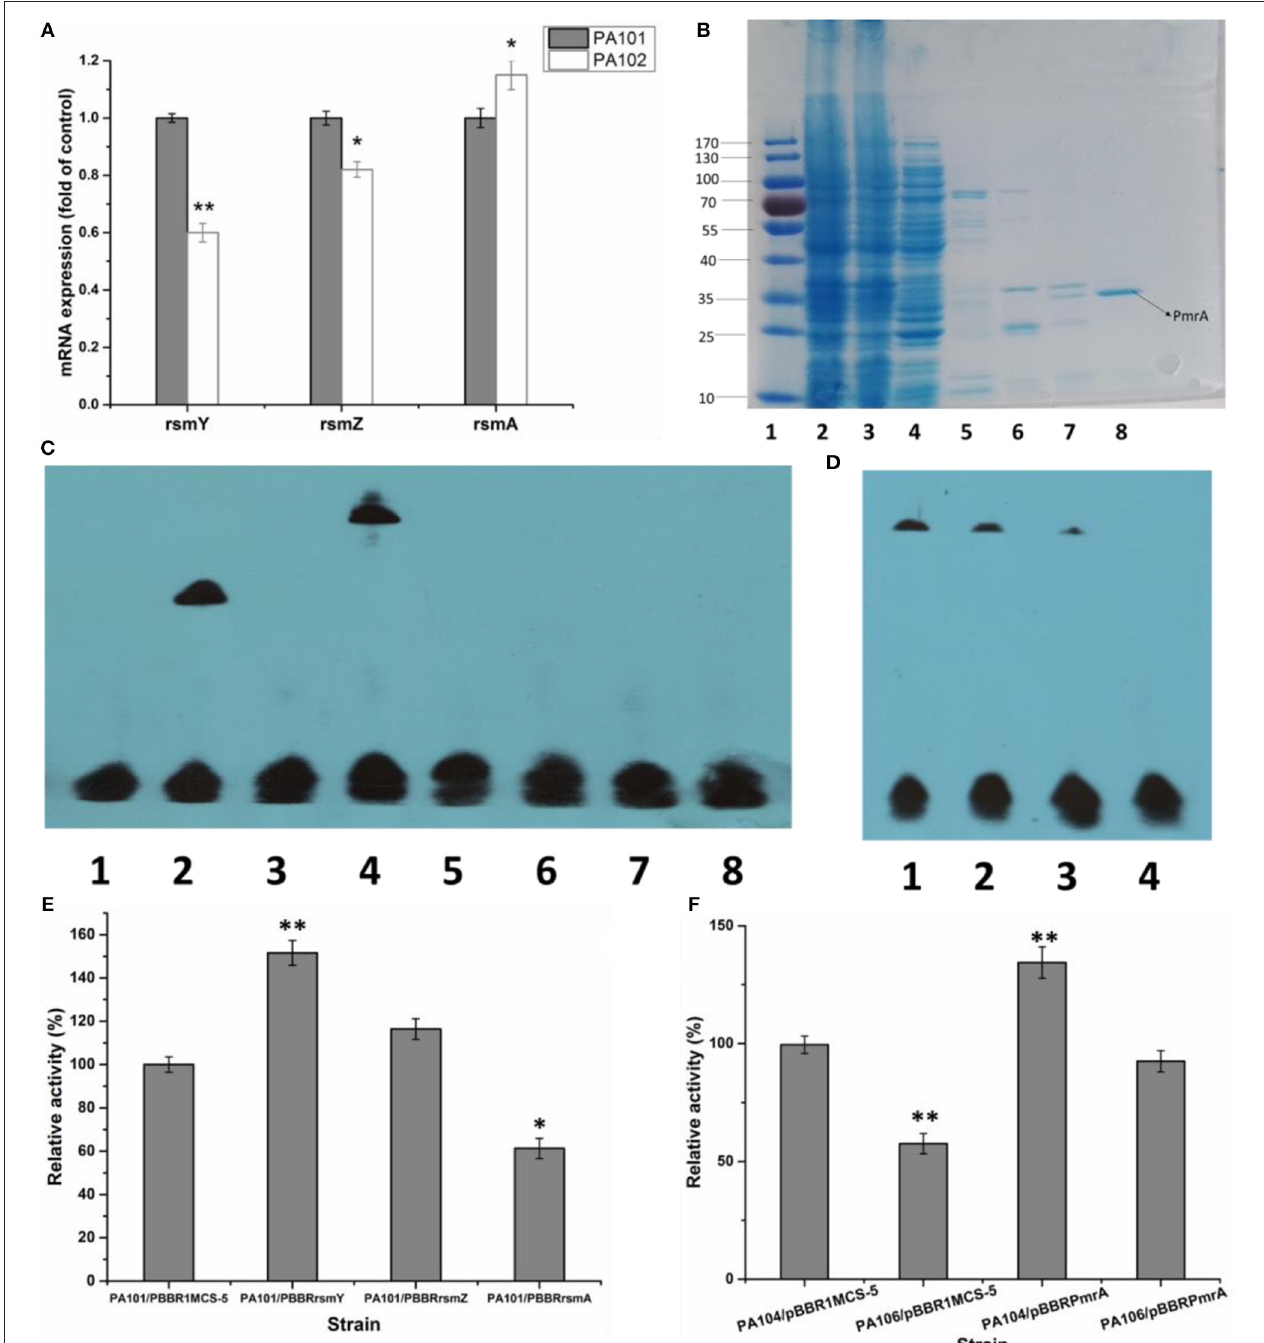
FIGURE 3 | Effect of PmrA overexpression on lipA expression. (A) QRT-PCR of rsmY , rsmZ, and rsmA in control strain (PA101; lane 1) and PmrA mutant strain (PA102; lane 2). Experiments were in triplicate. * P < 0.05, ** P < 0.01 compared with control group. (B) SDS PAGE of purified PmrA protein. Lane 1: protein molecular weight marker. Lane 2: whole cell lysate. Lane 3: liquid behind the column. Lane 4: NTA-30. Lane 5: NTA-60. Lane 6: NTA-100. Lane 7: NTA-200. Lane 8: NTA-500. (C) EMSA for binding of PmrA to rsmY/Z/A promoter sequence. Lane 1: negative control ( − ). Lane 2: positive control ( + ). Lane 3: rsmY. Lane 4: rsmY + PmrA. Lane 5: rsmZ. Lane 6: rsmZ + PmrA. Lane 7: rsmA. Lane 8: rsmA + PmrA. (D) PmrA protein bound to rsmY sequence, following increases in free rsmY . Ratios of free rsmY to biotin-labeled rsmY were 1:1, 50:1, 100:1, and 150:1 in groups 1 through 4. (E) Relative lipase activity in control strain (PA101) and overexpression strain (bar 1, control strain PA101/pBBR1MCS-5; bar 2, PA101/pBBRrsmY; bar 3, PA101/pBBRrsmZ; bar 4, PA101/pBBRrsmA). (F) Relative lipase activity (bar 1, control strain PA104/pBBR1MCS-5; bar 2, PA106/pBBR1MCS-5; bar 3, PA104/pBBRPmrA; bar 4, PA106/pBBRPmrA). Experiments were completed in triplicate. Experiments were completed in triplicate. * P < 0.05, ** P < 0.01, compared with the control.